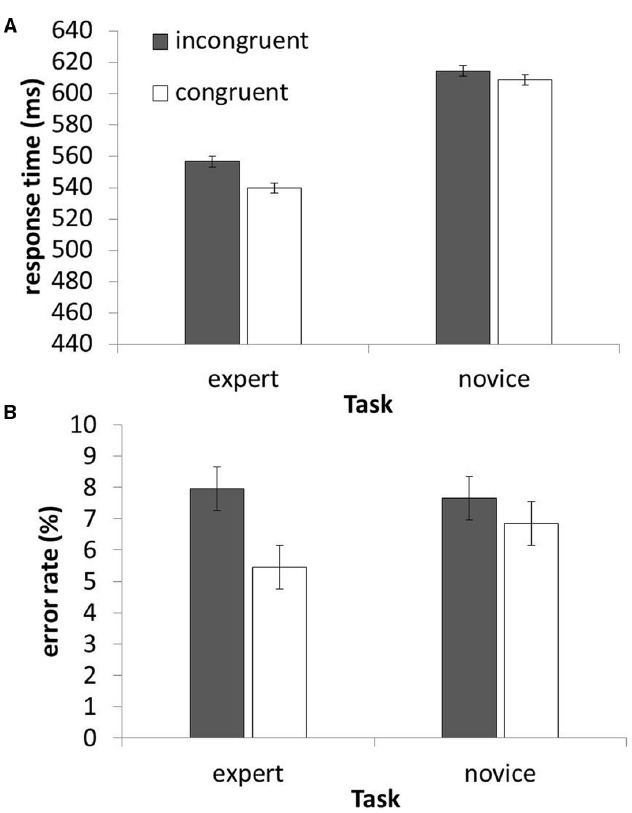
Results. RTs (A) and error rates (B) as a function of task (expert vs. novice) and response congruency. Error bars depict 95% within-subject confidence intervals (Loftus and Masson, 1994).